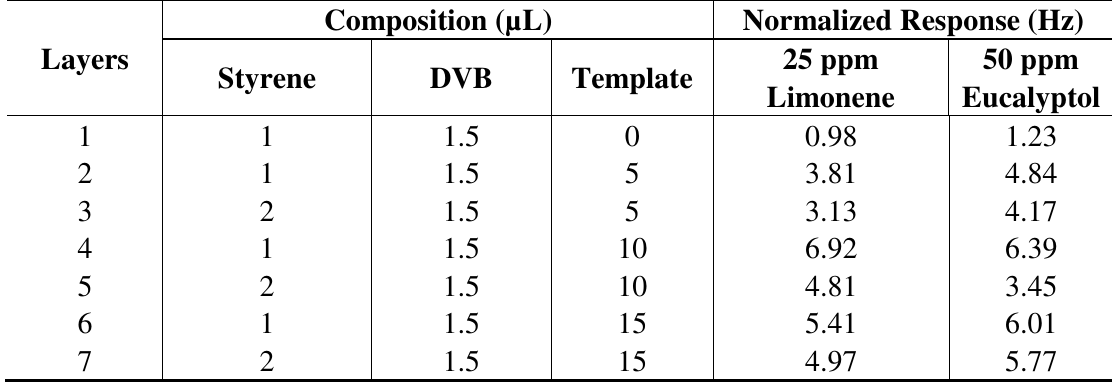
Table 1. Sensor responses to limonene and eucalyptol as function of MIP composition.